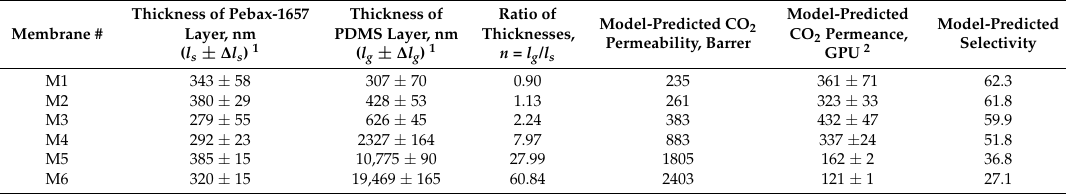
Table 2. Parameters of the fabricated membranes and expected values of total CO 2 permeability and CO 2 /N 2